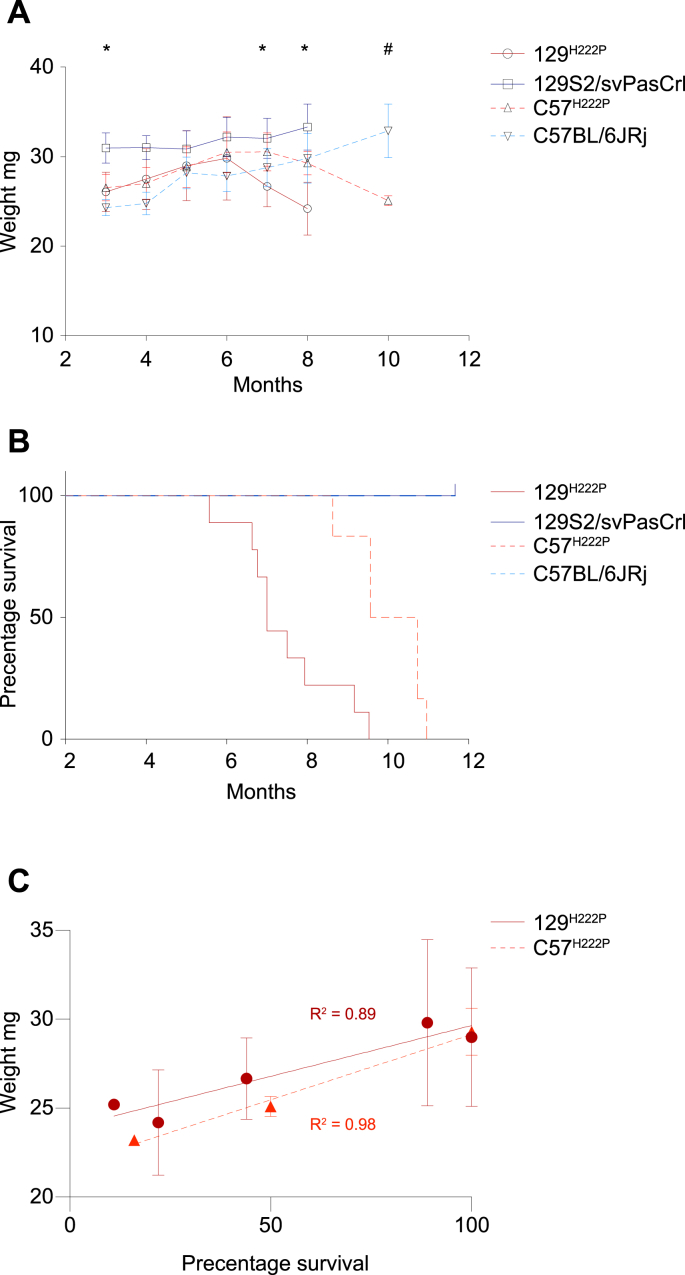
Effect of genetic background on the weight and the lifespan of 129Lmnap.H222P and C57Lmnap.H222P mice.(A) Weight curves for 129S2/svPasCrl (n = 12), 129Lmnap.H222P (n = 9), C57BL/6JRj (n = 8), and C57Lmnap.H222P (n = 6) mice. Values are presented as mean ± SD. Multiple group comparison was performed with Kruskal Wallis test with Dunn’s test post-test. *p ≤ 0.01 between 129Lmna p.H222P mice and 129S2/svPasCrl mice. #p ≤ 0.01 between C57Lmna p.H222Pand C57BL/6JRj mice.(B) Kaplan–Meier survival curves for 129S2/svPasCrl (n = 12), 129Lmnap.H222P (n = 9), C57BL/6JRj (n = 8), and C57Lmnap.H222P (n = 6) mice. Survival curves comparison was performed with the logrank test (mantel-cox test). **p ≤ 0.01 between C57Lmnap.H222P and 129Lmnap.H222P mice. ####p ≤ 0.0001 between 129Lmnap.H222P mice and 129S2/svPasCrl mice.(C) Regression analysis of weight and survival percentage for 129Lmnap.H222P and C57Lmnap.H222P mice. Values are presented as mean ± SD.